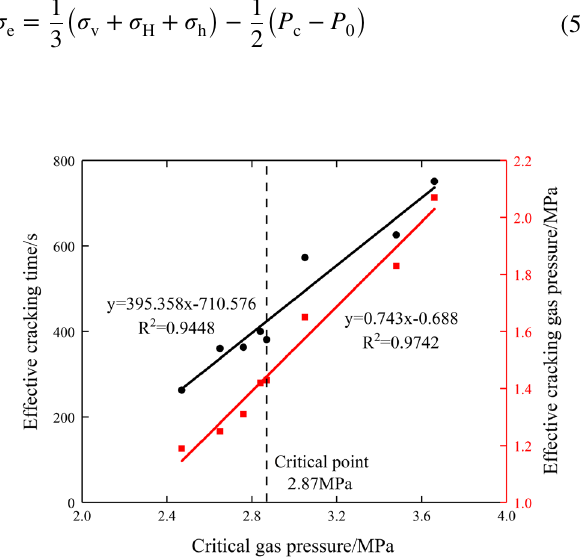
Fig. 9 Variation of effective cracking time and effective cracking gas pressure with effective